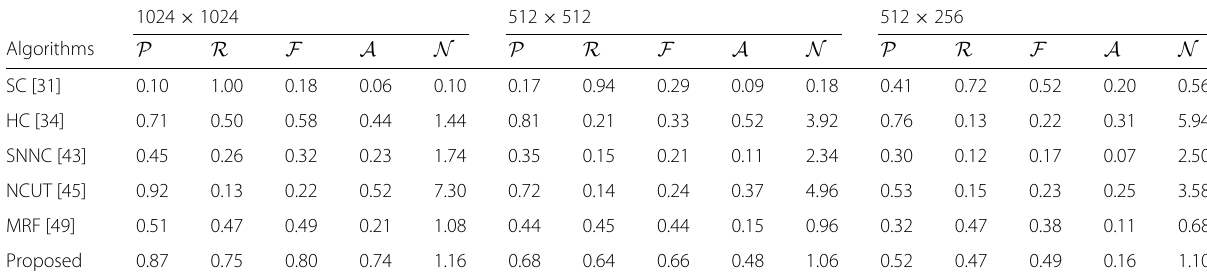
Table 3 Comparison of clustering algorithms on D 3